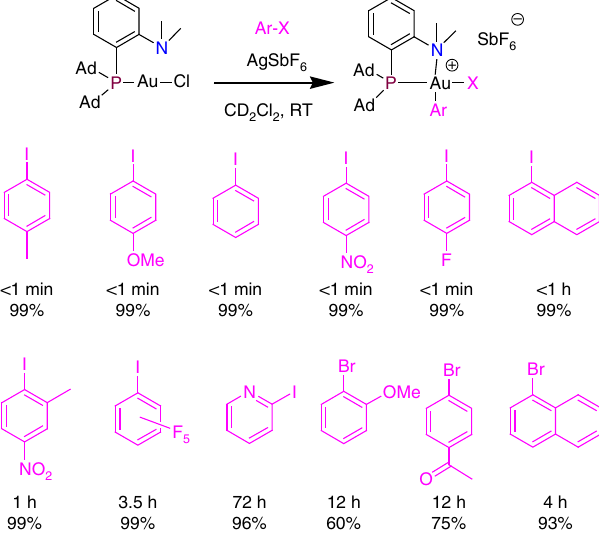
lysis (Fig. 2b) con fi rmed κ 2 – (P,N) coordination of the